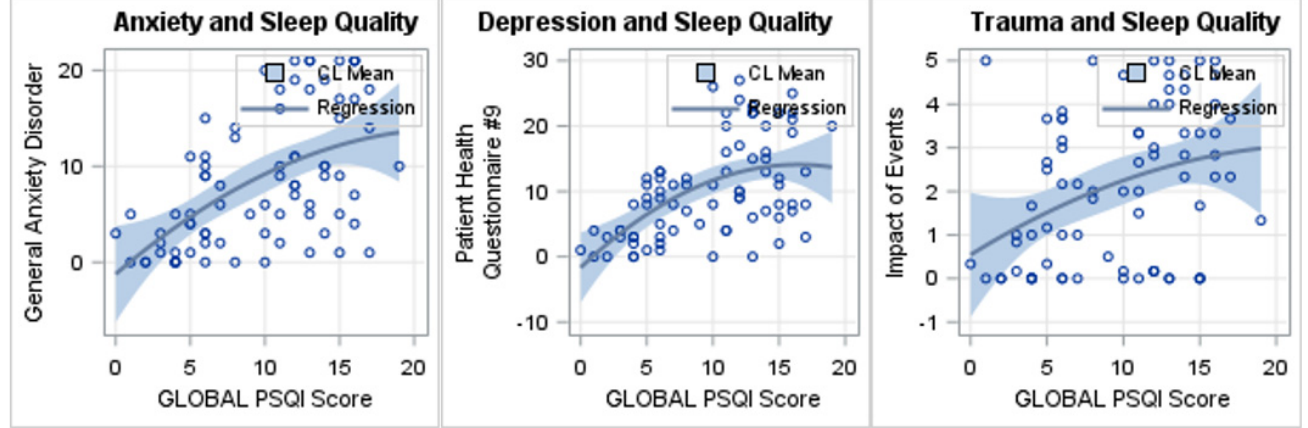
Figure 1. Linear regression plots between sleep quality (global PSQI) and outcomes.